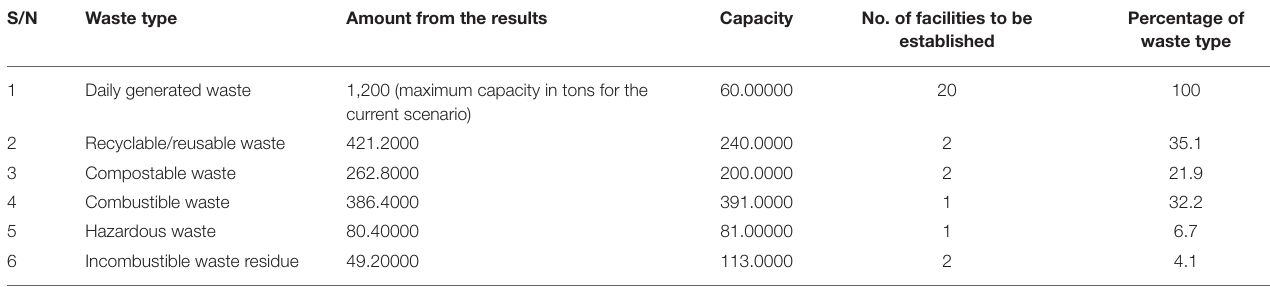
TABLE 3 | Values of major categories waste with their